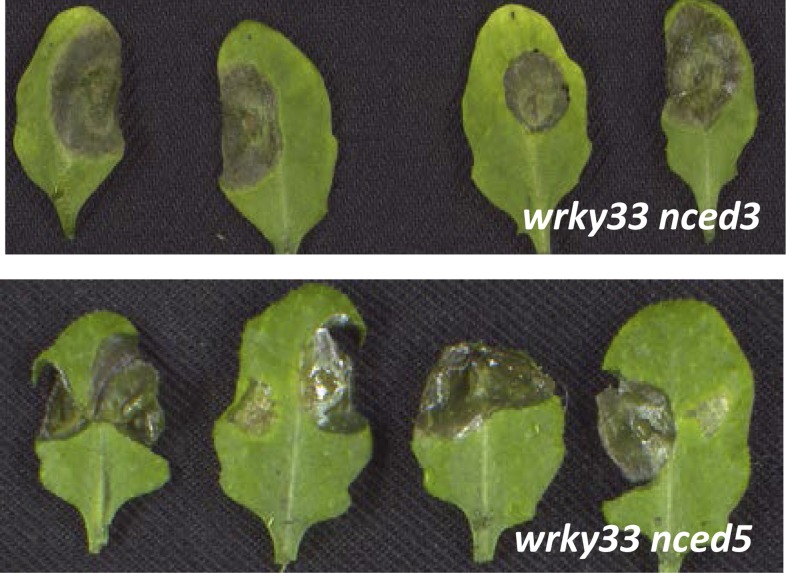
B. cinerea 2100 infection phenotypes of mature 4-week old leaves derived from wrky33 nced3 and wrky33 nced5 mutant plants.Pictures were taken 3 days post inoculation of two 2 μl droplets containing 2.5 × 105 spores to each leaf (leaves were detached after completion of the experiment for photographic purposes only).